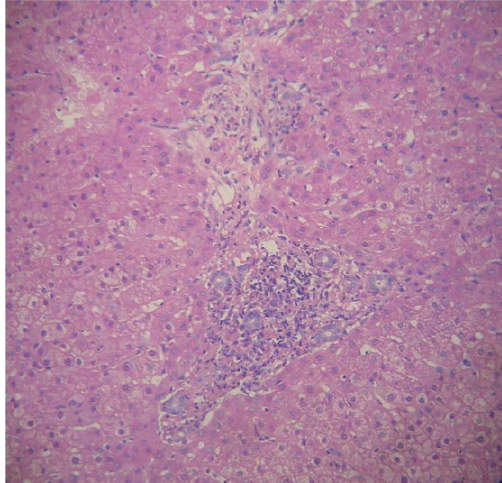
Figure 4 - Histology of the liver graft illustrating canalicular biliary proliferation. Note the proliferated ducts in the periphery of the